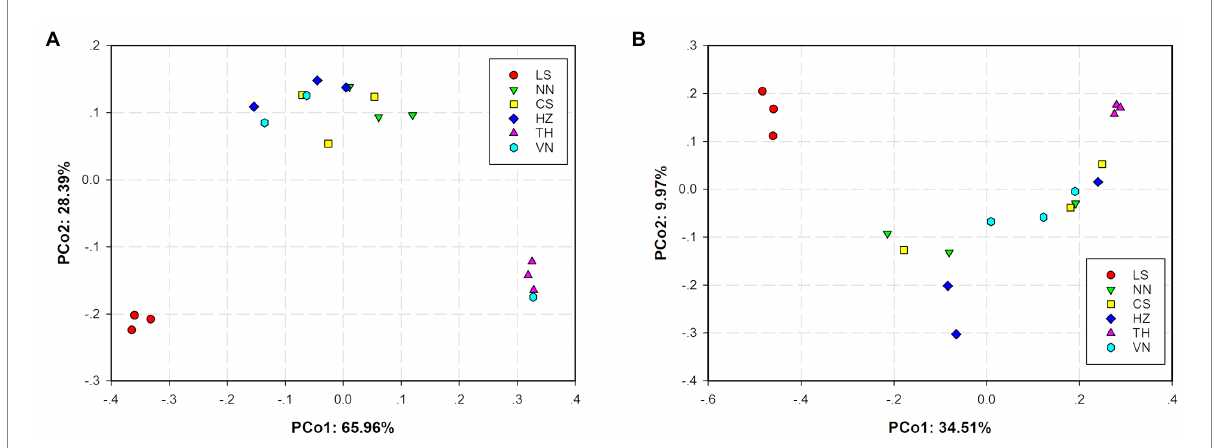
FIGURE 3 Principal coordinate analysis (PCoA) of bacterial communities in C. medinalis from different geographic sources based on weighted UniFrac (A) and Bray–Curtis (B) distances.